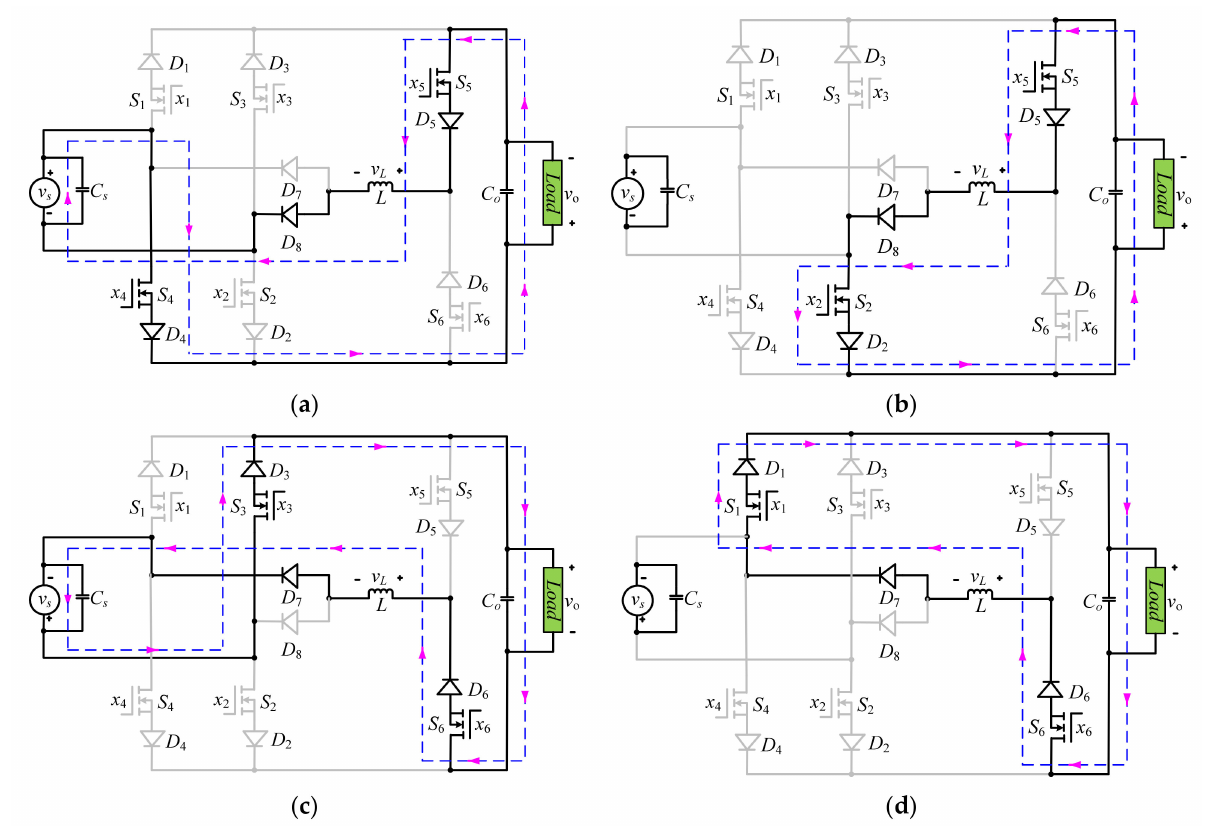
Figure 4. Equivalent current-conducting loops with respect to the input voltage to produce inverting buck operation during; ( a , b ) positive half cycles; ( c , d ) negative half